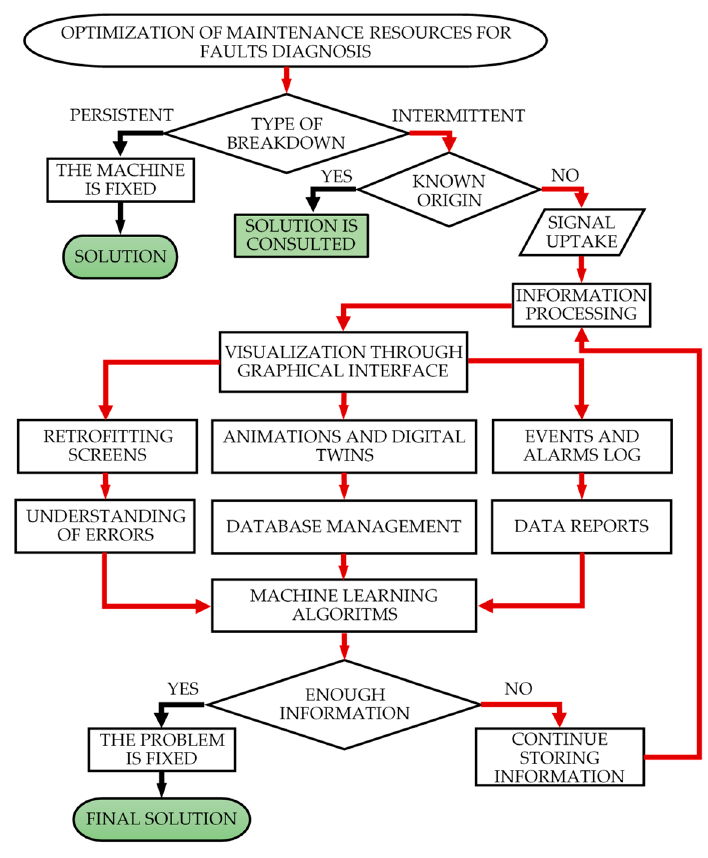
Figure 2. Flowchart for fault diagnosis and resolution.